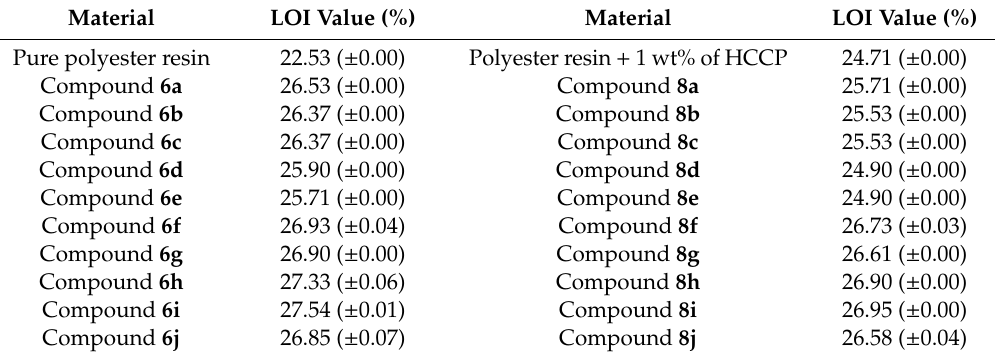
Table 4. LOI test